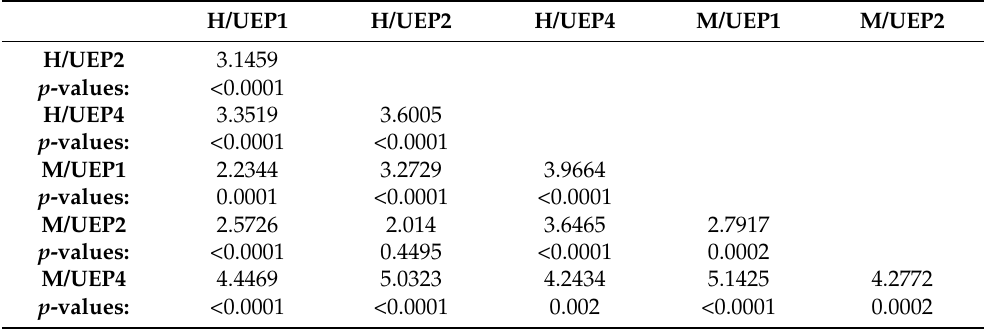
Figure 6. Canonical variate analysis of Caquetaia kraussi localities and sex in three populations in Colombia. Pink: female UEP1; red: male UEP1; light green: female UEP2; dark green: male UEP2; light blue: female UEP4; and dark blue: male UEP4. Table 3. Permutation test based on Mahalanobis distances and their corresponding p -values of the comparison between populations and sexes of C.